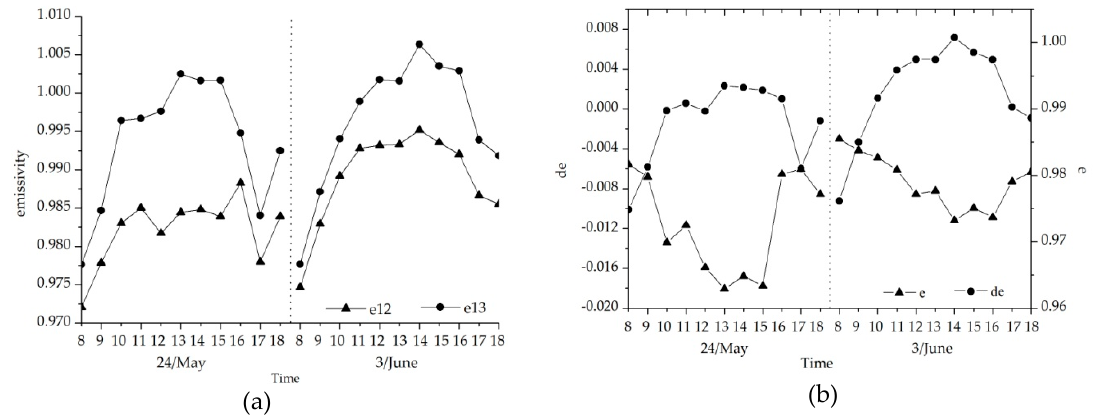
Figure 6. The diurnal variations of measured emissivity, where ( a ) is the band emissivity corresponding to the 12th and 13th channels of FY-4A (referred to as e12 and e13), and ( b ) is the variations of mean and di ff erences of emissivity (referred to as e and de) of the 12th and 13th channels of